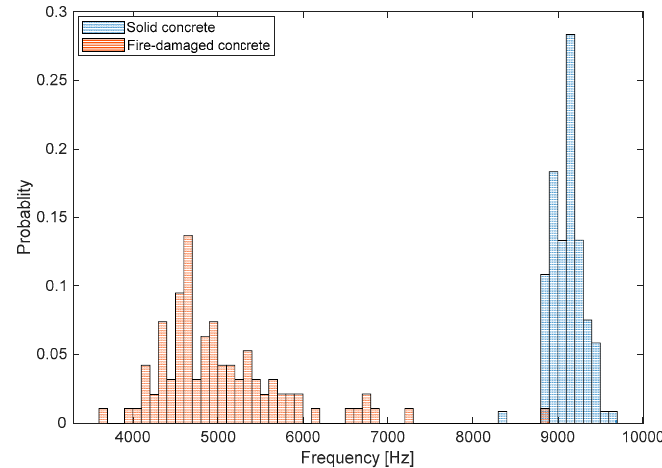
Figure 13. Histograms representing the distribution of peak frequency values measured on the bottom surfaces of solid and fire-damaged concrete slab specimens. Table 1. Summary of a statistical analysis: K-S test results and mean, standard deviation and coefficient of variation of data sets from two sound and fire-damaged concrete slabs in this study.